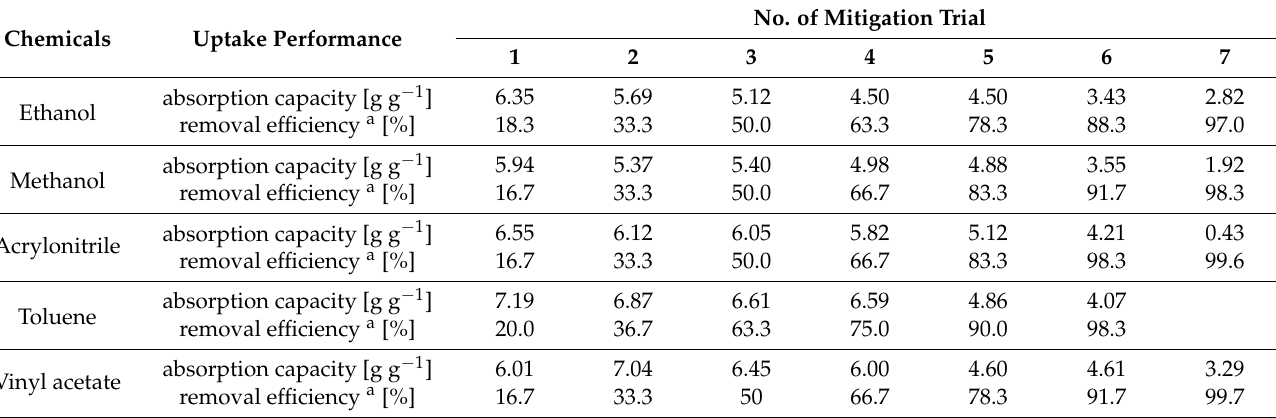
Table 4. Summary on mitigation performance of the prototype absorption assembly for five different organic compounds.